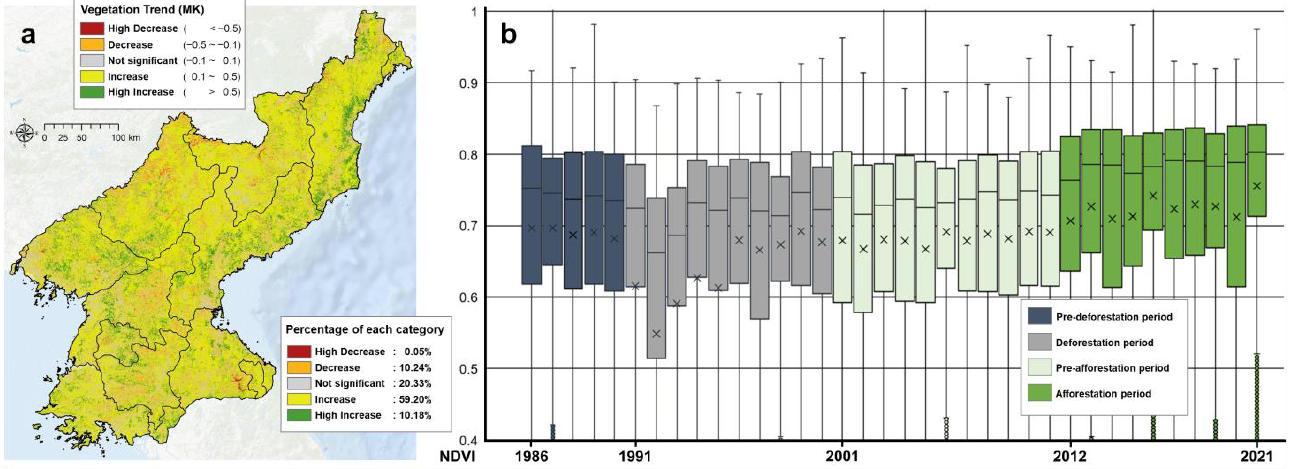
Figure 3. Spatiotemporal trend of 1986 – 2021 ( a ) and time-series change of national average vegetation greenness ( b ).